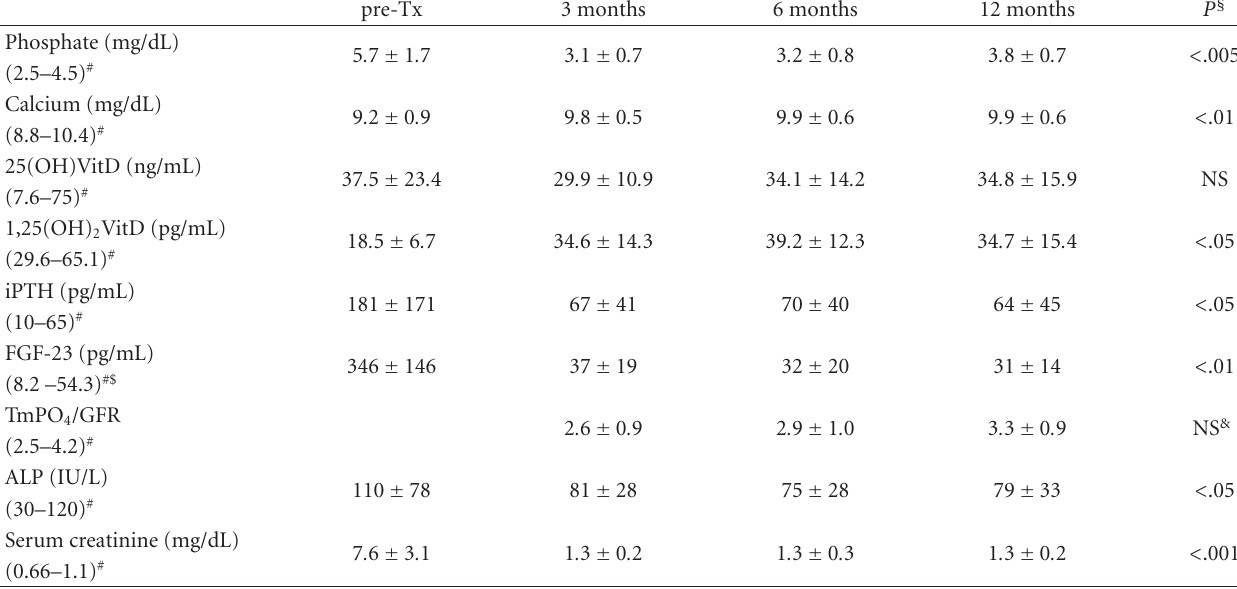
Table 1: Evolution of studied parameters over the first 12 months following kidney transplantation.